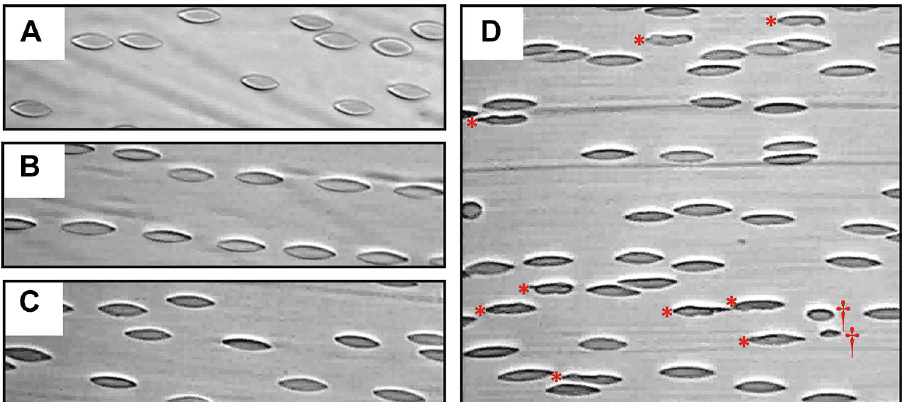
Figure 2. Micrograph of red blood cells (RBC) in shear flow instantaneously imaged at 300 s of exposure to 10 Pa ( A ), 30 Pa ( B ), 40 Pa ( C ), and 60 Pa ( D ). RBC with abnormal morphology (*) and RBC fragments/ extracellular vesicles (†) can be observed.